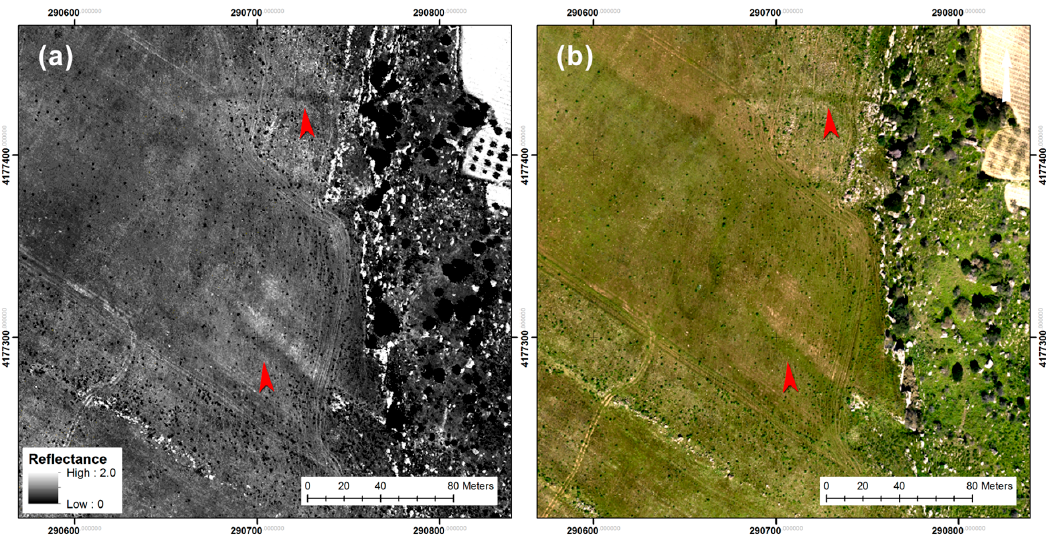
Figure 12. Vegetation marks indicating the presence of a ditched settlement structure. ( a ) 50 cm spatial resolution contrast stretched calibrated reflectance image of vegetation marks indicating ditched structure; ( b ) 50 cm spatial resolution contrast stretched RGB image of vegetation marks indicating ditched structure. Red arrows indicate location of vegetation marks. Coordinate system: WGS84 UTM Zone 33N.